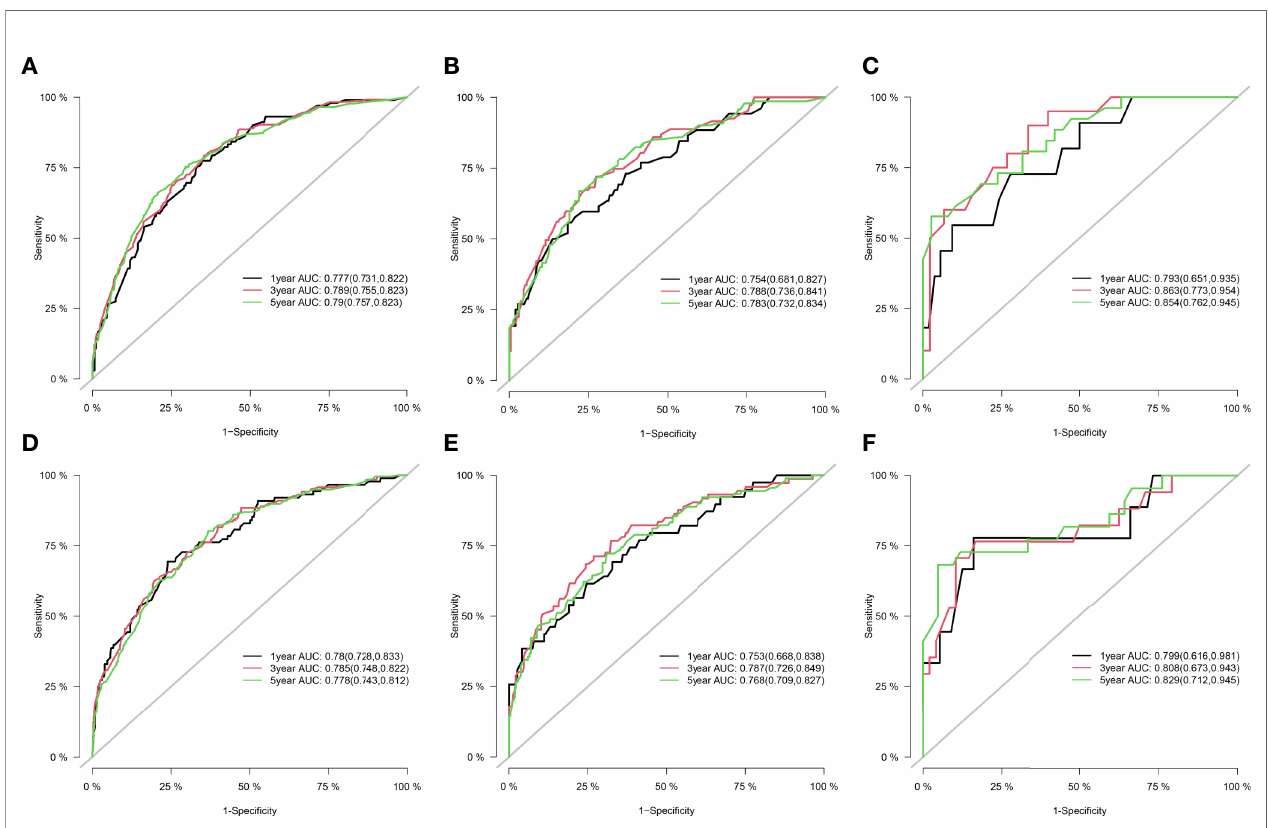
FIGURE 2 | ROC curve for the nomograms in predicting prognosis in patients with RPLs. (A) ROC of 1-, 3-, and 5-year OS in the training cohort. (B) ROC of 1-, 3-, and 5-year OS in the internal validation cohort. (C) ROC of 1-, 3-, and 5-year OS in the external validation cohort. (D) ROC of 1-, 3-, and 5-year CSS in the training cohort. (E) ROC of 1-, 3-, and 5-year CSS in the internal validation cohort. (F) ROC of 1-, 3-, and 5-year CSS in the external validation cohort. ROC, receiver operating characteristic; OS, overall survival; CSS, cancer-speci fi c survival; RPLs, retroperitoneal liposarcomas.